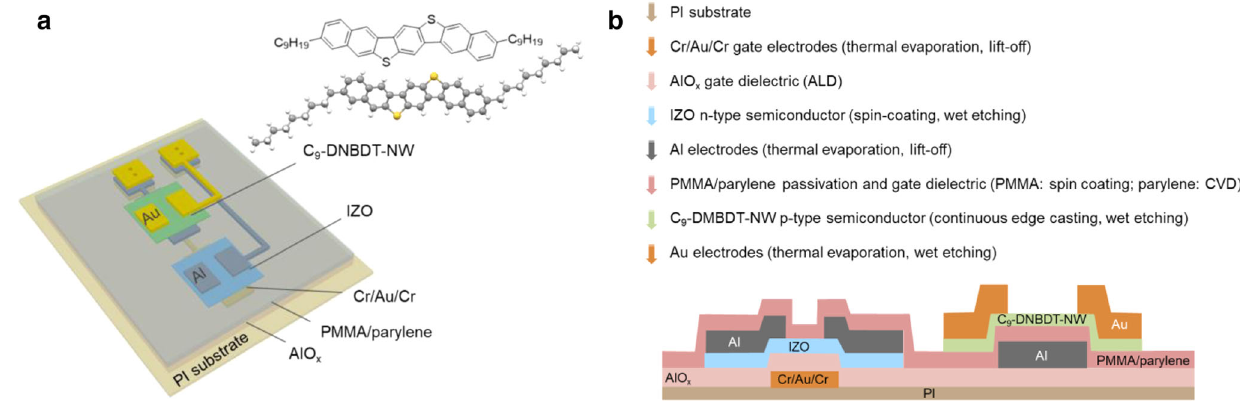
Fig. 1 Schematic structure, process fl ow and cross section of a hybrid complementary inverter with IZO as the n-channel material and C 9 -DNBDT-NW single crystal as the p-channel material. a Schematic device structure. b Process fl ow and